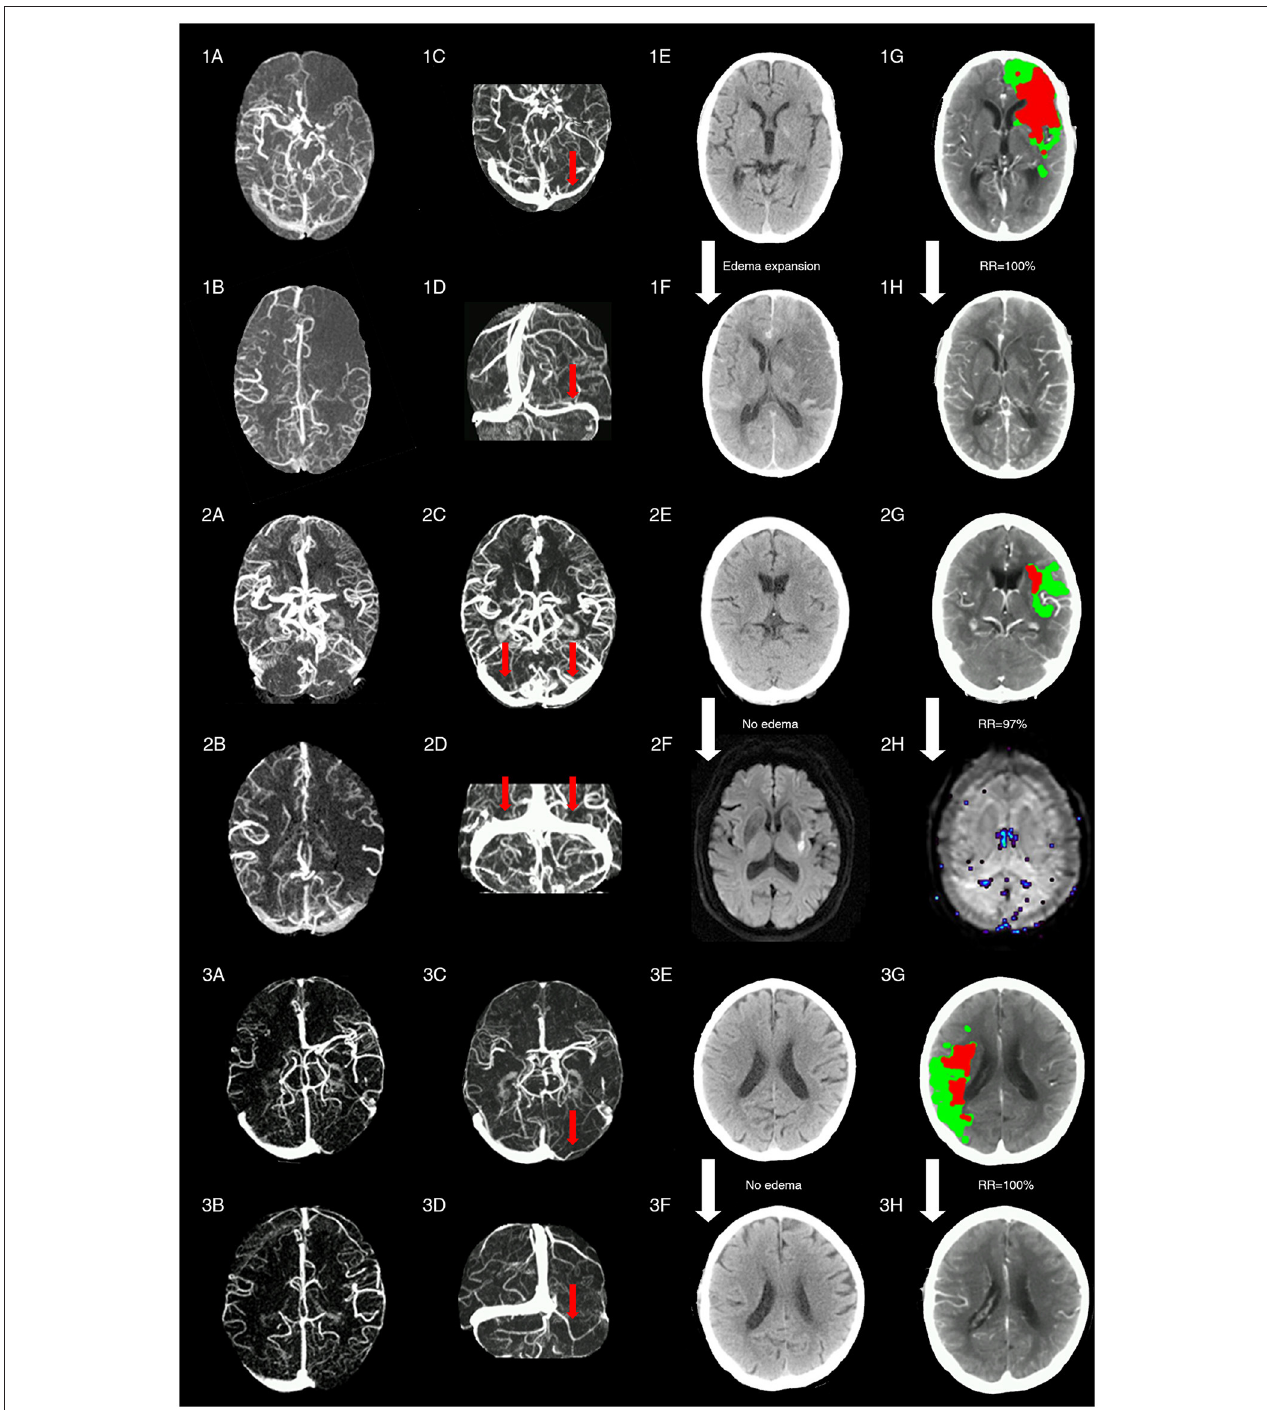
FIGURE 4 | Representative images of patients with different status of ipsilateral transverse sinus and collaterals. Patient 1 with acute left middle cerebral artery occlusion (MCAO) (baseline NIHSS = 14) presented with poor collaterals [integrated collateral grading scale (CGS) = 0] (1A,1B) and FDITS (the red arrow in 1C,1D) on 4-dimensional computed tomographic angiography (4D-CTA). The patient received intravenous thrombolysis bridging with endovascular therapy at 2.5h from stroke onset. At 24h after reperfusion therapy, this patient developed brain edema expansion on non-contrast CT (NCCT) from baseline score 0 (1E) to 2 (1F), although reperfusion rate was 100% with hypoperfusion (red plus green area) volume changing from 220ml (1G) to 0ml (1H) on lesion map. The modified Rankin scale (mRS) score was 4 at 3 months. Patient 2 with acute left MCAO (baseline NIHSS = 13), presented with good collaterals (CGS = 2) (2A,2B) and symmetric bilateral transverse sinuses (non-FDITS) (two red arrows in 2C,2D) on 4D-CTA. The patient received intravenous thrombolysis at 4h from stroke onset. At 24h after